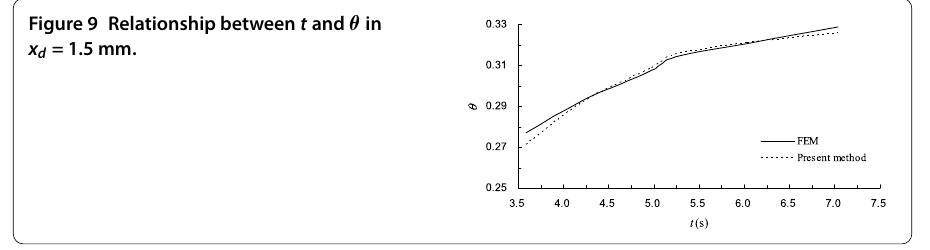
Figure 9 Relationship between t and θ in x d = 1.5 mm.